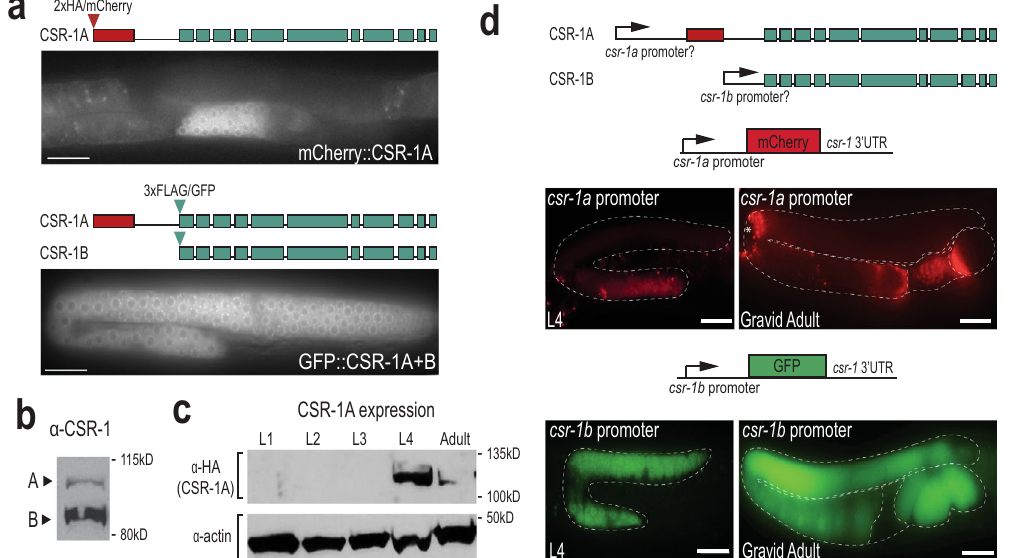
Fig. 1 CSR-1 isoforms have distinct spatial and temporal expression patterns. a Live imaging of CSR-1A (top) and CSR-1A + B (bottom) in an L4 hermaphrodite germline. At least three individual germlines were imaged for each strain. Scale bars, 25 μ M. b Western blot detecting CSR-1 expression, using α -CSR-1 antibodies, in wild-type animals at L4 stage. c Western blot detecting for CSR-1A at each larval stage and gravid adult in 2xHA::mCherry:: CSR-1A strain using α -HA antibody. Actin is shown as a loading control. d Schematic representation (top) of putative csr-1a and csr-1b promoters driving mCherry and GFP. The csr-1a promoter comprises ~1.5 kb of sequence preceding the fi rst csr-1a exon, and the csr-1b promoter is the entire 544-bp intron between the unique csr-1a exon and the start codon of csr-1b . Schematic of the promoter reporter constructs created using the MosSCI system for csr-1a (middle) and csr-1b (bottom) are shown above images of gonads from L4 and gravid adult stages expressing the reporter constructs. Asterisk indicates intestinal auto fl uorescence visible near the bend in adult csr-1a::mCherry gonad. At least three individual germlines were imaged for each strain and condition. Scale bars, 25 μ M. All blots have been reproduced. Source data are provided as a Source data fi